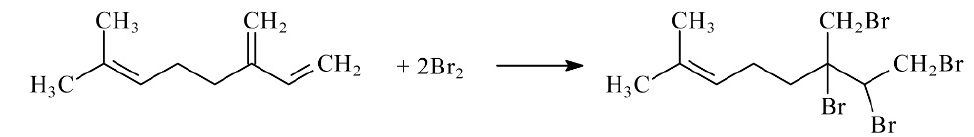
Figure 3. The structure of the terpenes under consideration. Scheme 1. Reaction of myrcene with electrogenerated bromine.